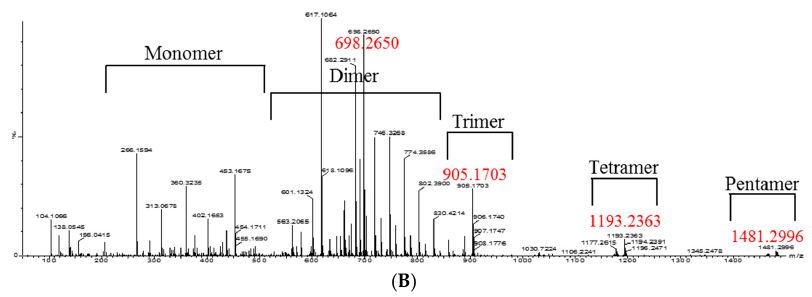
Figure 3. The ESI-MS observation of synthesis of oligomeric anthocyanins from monomeric anthocyanin using Aspergillus niger . ( A ) Before biosynthesis; ( B ) after biosynthesis.